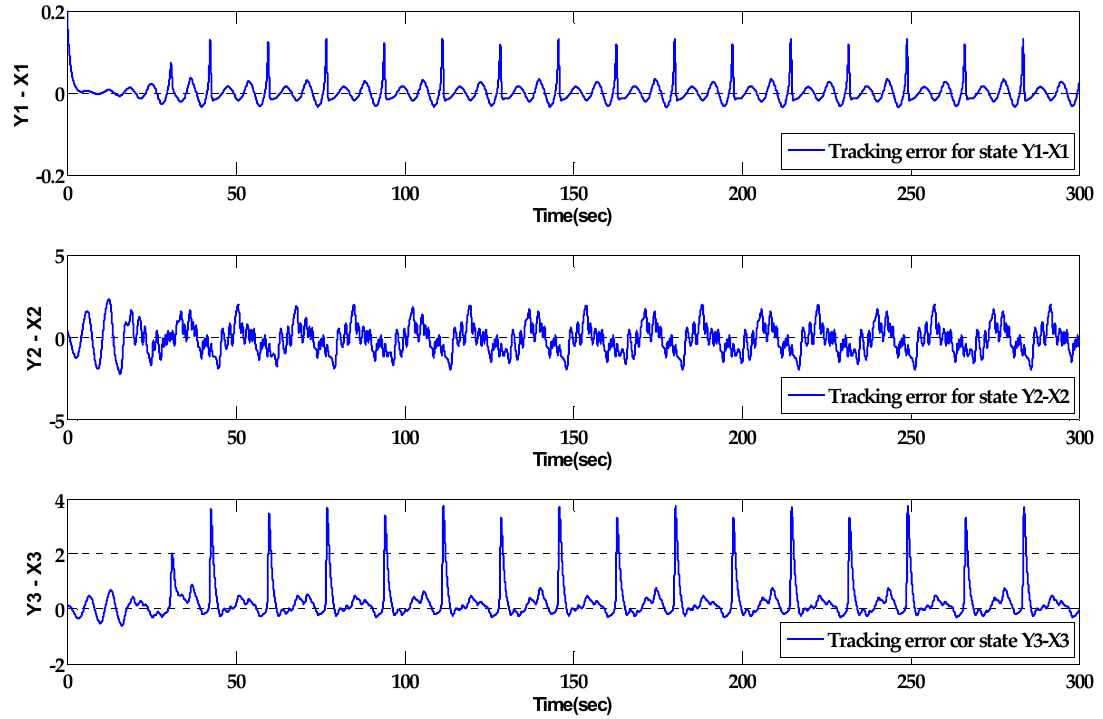
Figure 4. The tracking error between the Rossler and RCLs-JJ systems through an active control procedure.